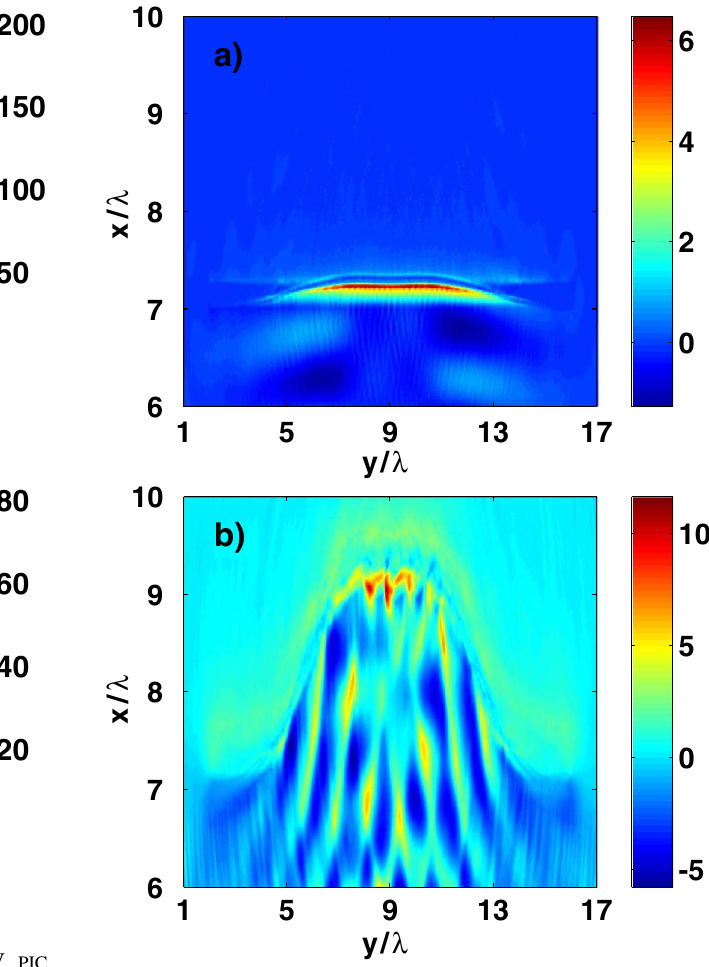
FIG. 9. (Color) Electric field in the laser incidence direction, E , x c!=e ). The simulation parameters in the normalized units ( m e and time instants are the same as in Fig. 8. At the interaction time 28 (cid:2) the field in the central part contains also the specularly reflected part of the laser wave.